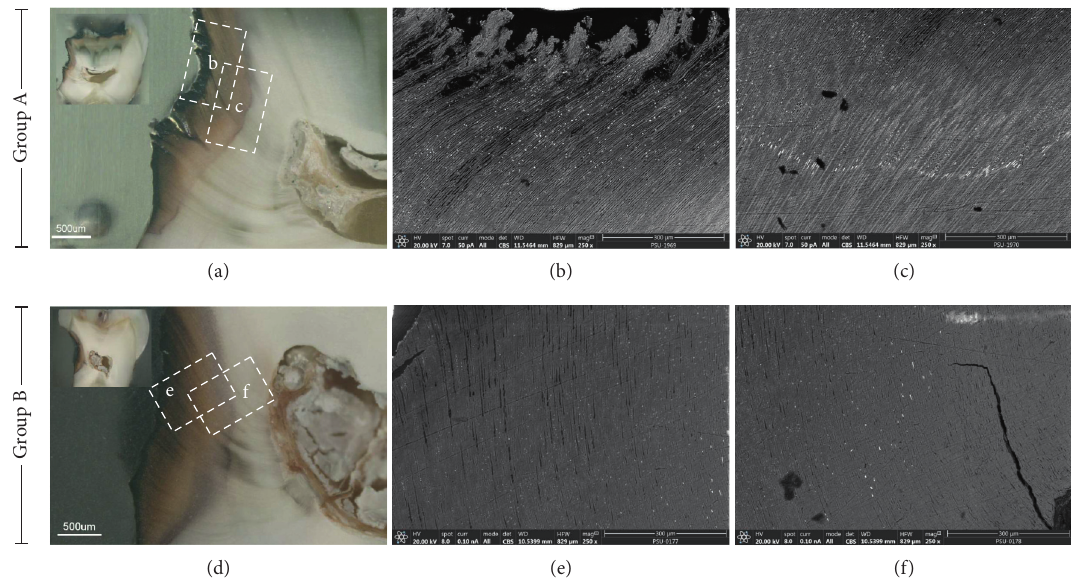
Figure 3: Cross-sectional stereomicroscope images of carious lesions treated with SDF and corresponding SEM micrographs at 250x magnification in group A (a–c) and B